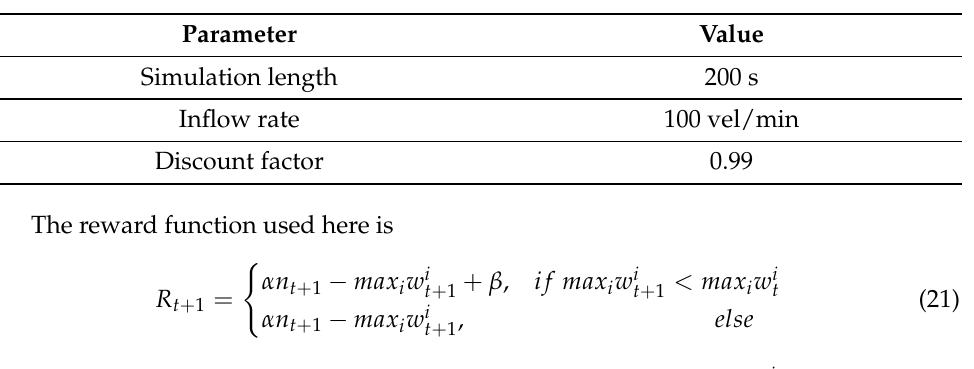
Table 5. Parameters used in simulations.